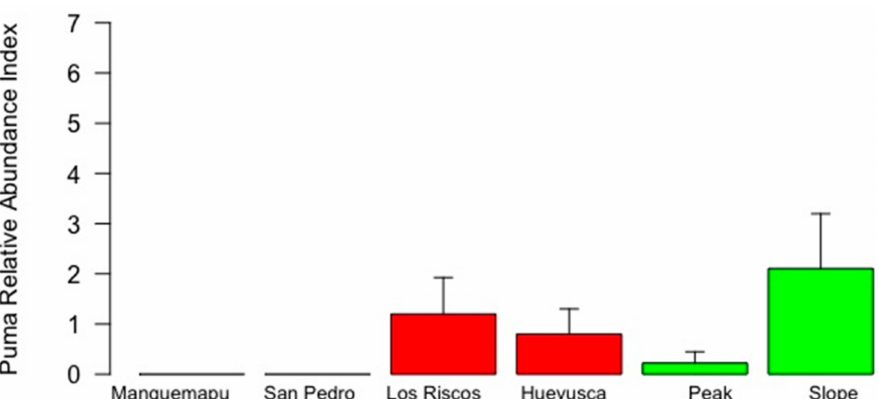
Figure 4. Puma RAI in six locations of the coastal range of southern Chile (whiskers represent 1 standard error). White, red and green bars identify coast, pre-mountain range and mountain range landscapes, characterized by intermediate, high and low degrees of human intervention, respectively.